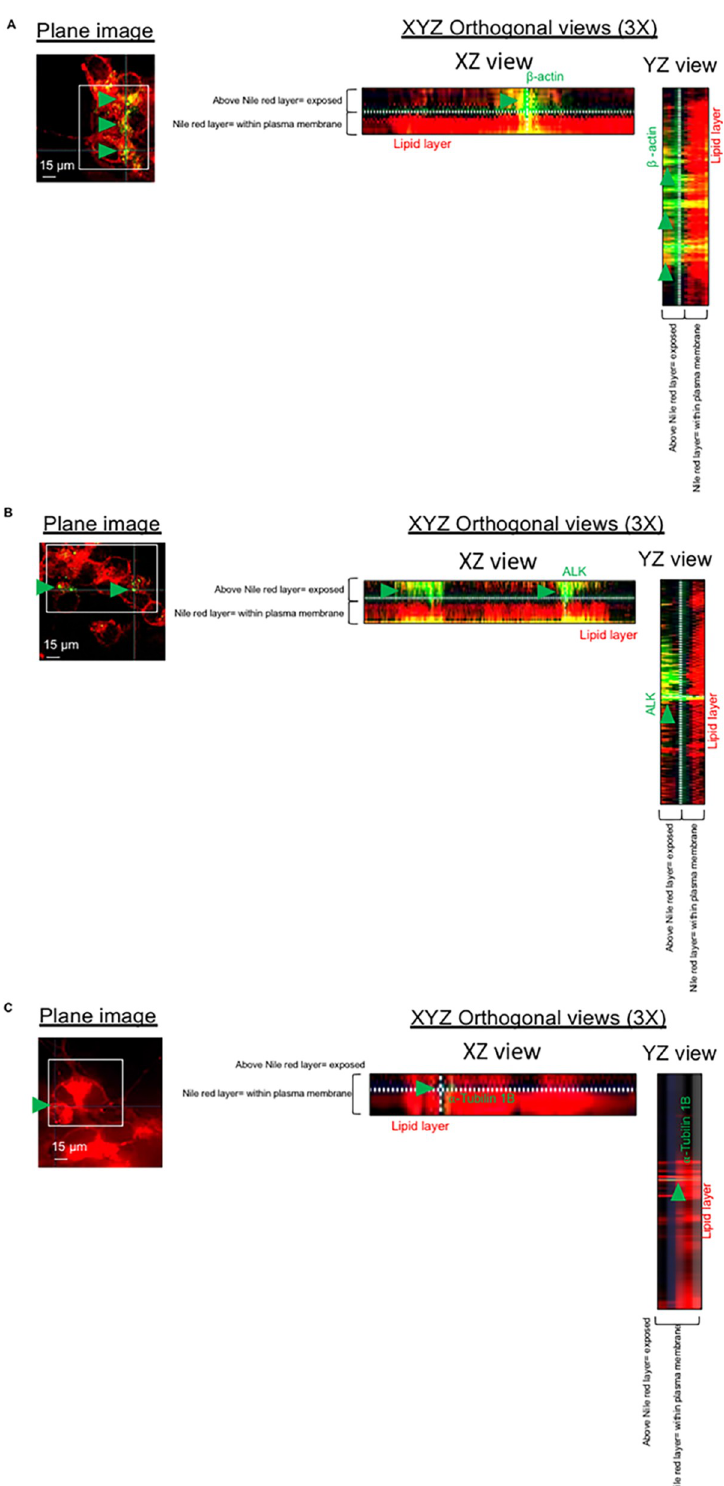
Fig 4. Exposure of β -actin on the plasma membrane of neurons. Immunofluorescence microscopy analysis showing fixed and non-permeabilized neurons and stained for nile red for the detection of plasma membrane lipids; neurons were co-stained with anti- β -actin antibody ( A ), anti-ALK antibody ( B ) and anti- α -tubulin 1B antibody ( C ). 3D- orthogonal views were used to assess whether the detection of β -actin antibody (A), anti-ALK antibody (B) and anti- α -